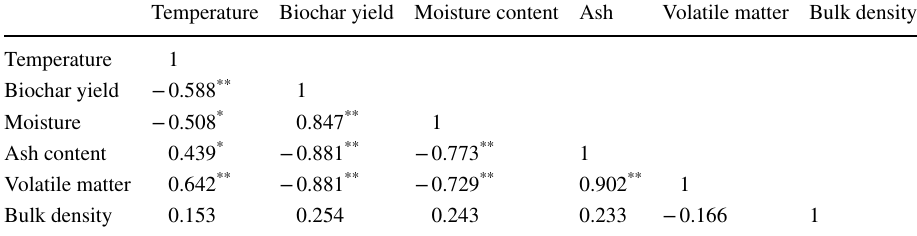
Table 4 Correlation matrix among the physical properties biochar issued from crop wastes